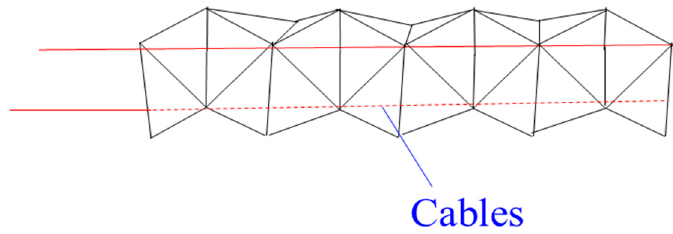
Figure 10. An origami CCR with a cable-driven system